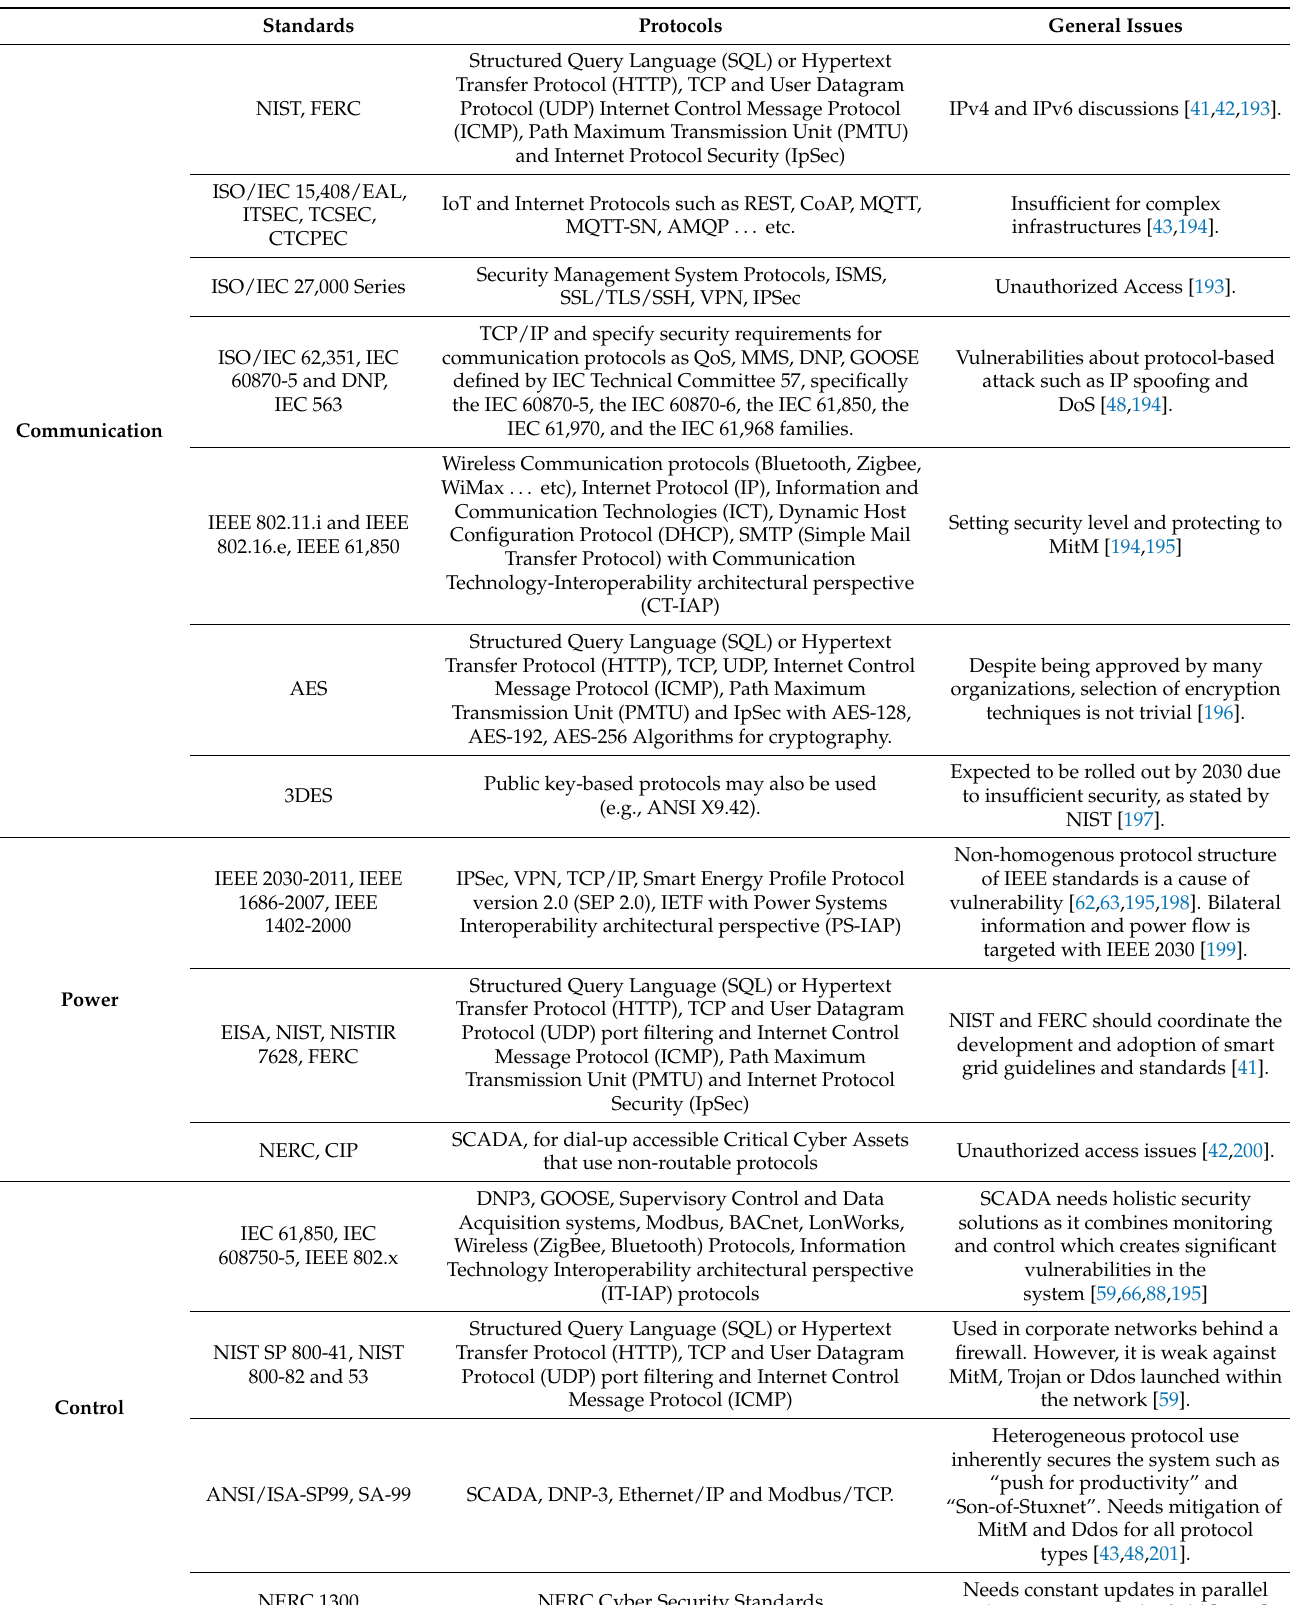
Table 4. Vulnerabilities of